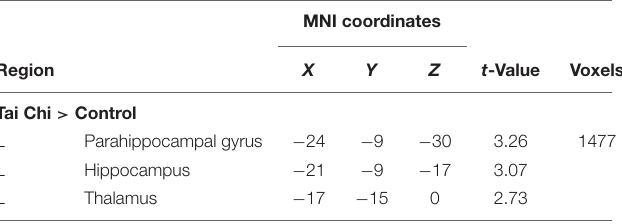
TABLE 2 | Anatomical and statistical information of the cluster in which significant between-group differences in gray matter volume (GMV; i.e., Tai Chi group > Control group) were